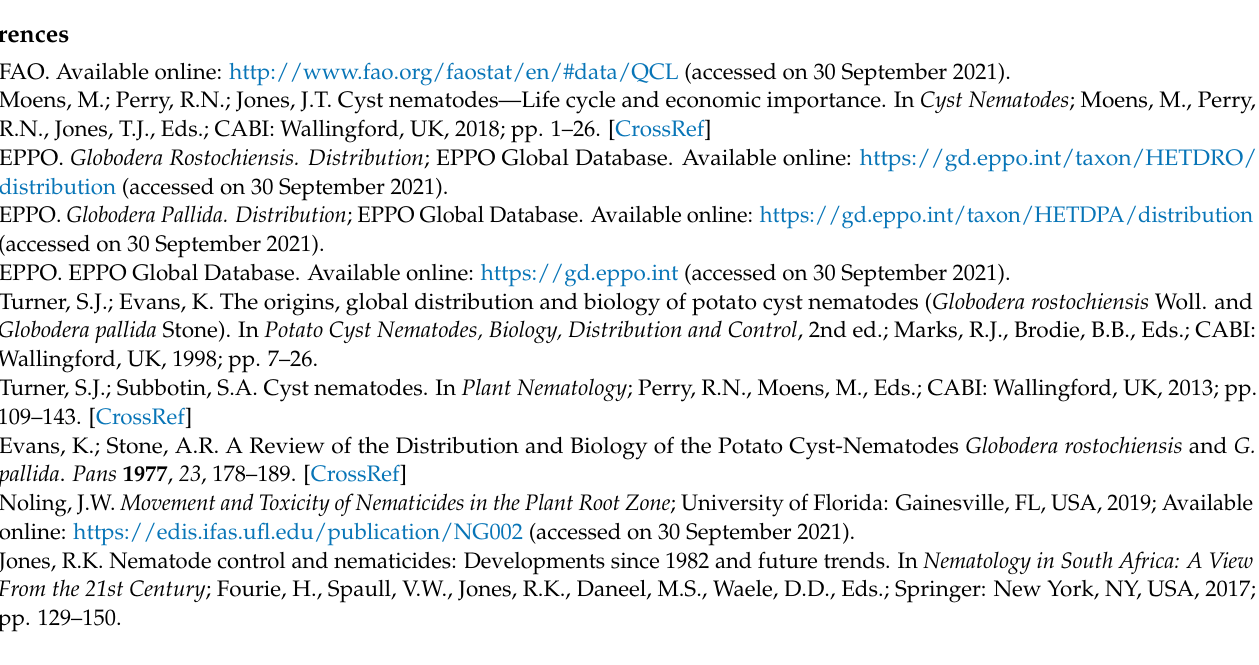
for identification of Gpa2 gene, Figure S2: Diagnostic bands (indicated by an arrow) of TG432/RsaI (A) and GP179/RsaI (B) markers for identification of Grp1_QTL , Figure S3: Diagnostic bands of HC marker for identification of GpaV vrn _QTL locus, Figure S4: Diagnostic band of GP21/DraI marker (indicated by the arrows) for identification of Grp1_QTL , Figure S5: Diagnostic bands of markers GP34/TaqI (indicated by the arrows) for identification of Gpa2 gene, Figure S6: Diagnostic bands (indicated by the arrows) of markers GP179/EcoRV for locus GpaVs spl _QTL, Figure S7: Restricted DraI- fragments of PCR-products amplified from potato cultivars’ DNA used primers